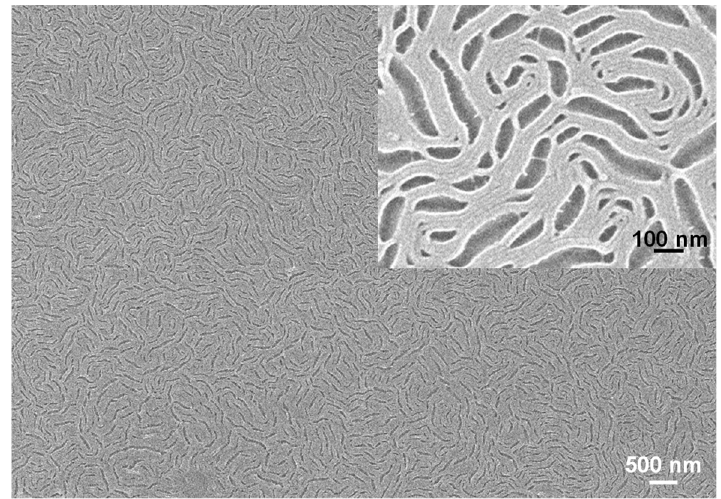
Figure 2. Low- and high-magnification SEM images of a P(S 21 -b-M 21 ) film of h i = 97 nm. The film